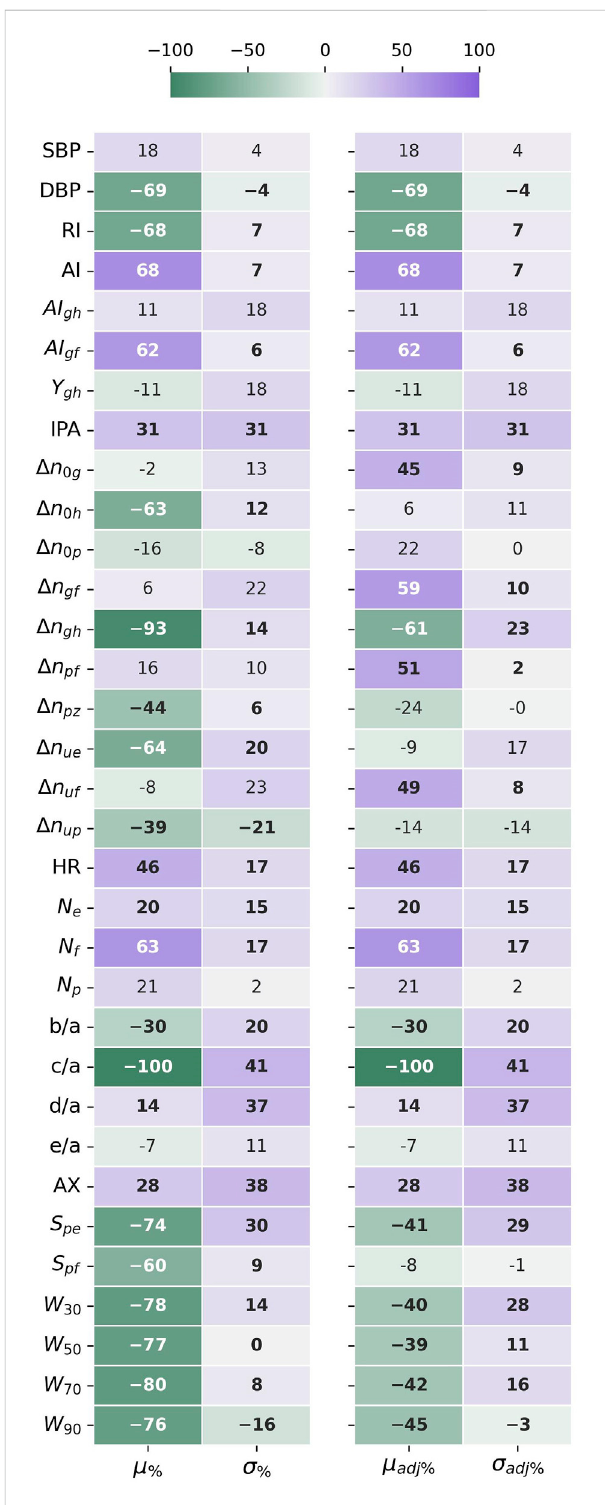
FIGURE 3 Thedifferenceinmean( μ %)andstandarddeviation( σ %)between the datasets, given as a percentage standard deviation of the joined datasets. The HR adjusted forms ( μ adj%) and ( σ adj%), compensate for the different HR distributions affecting time sensitive features. Negative values indicate that the mean or std values for UCI are lower than for PPG-BP. Values in bold indicate signi fi cantly different distributions (p < 0.001) according to the Kolmogorov-Smirnov